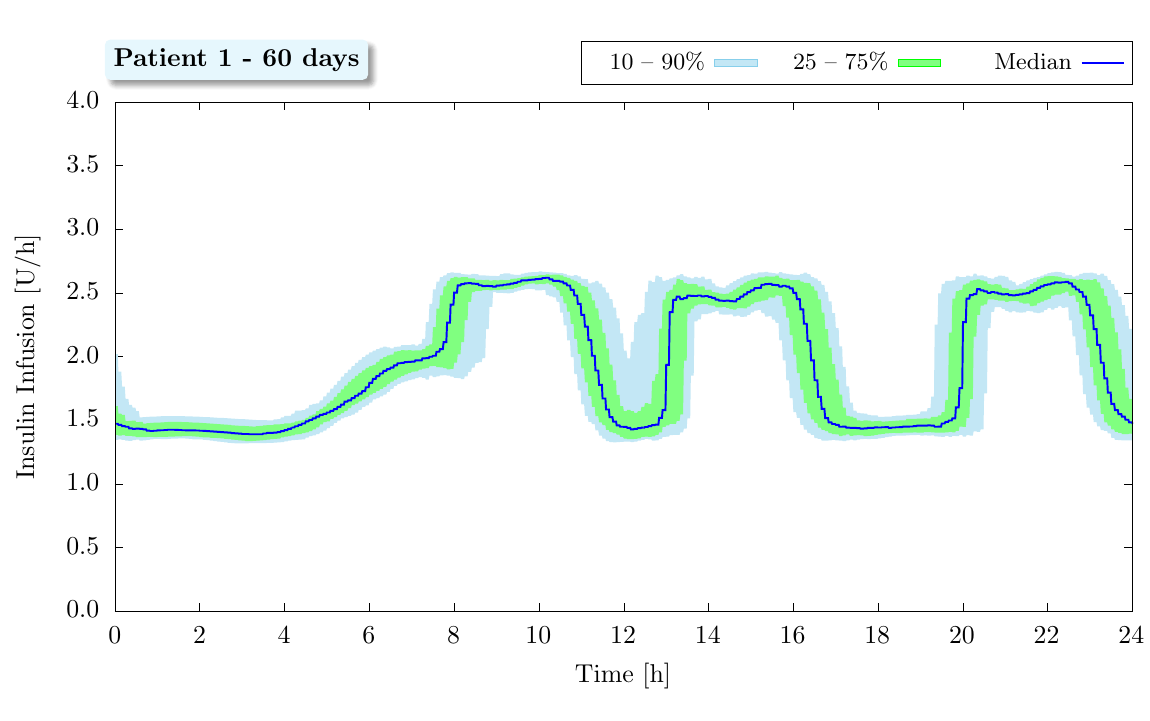
Figure 8. Insulin profile of patient 1 with median and interpercentile